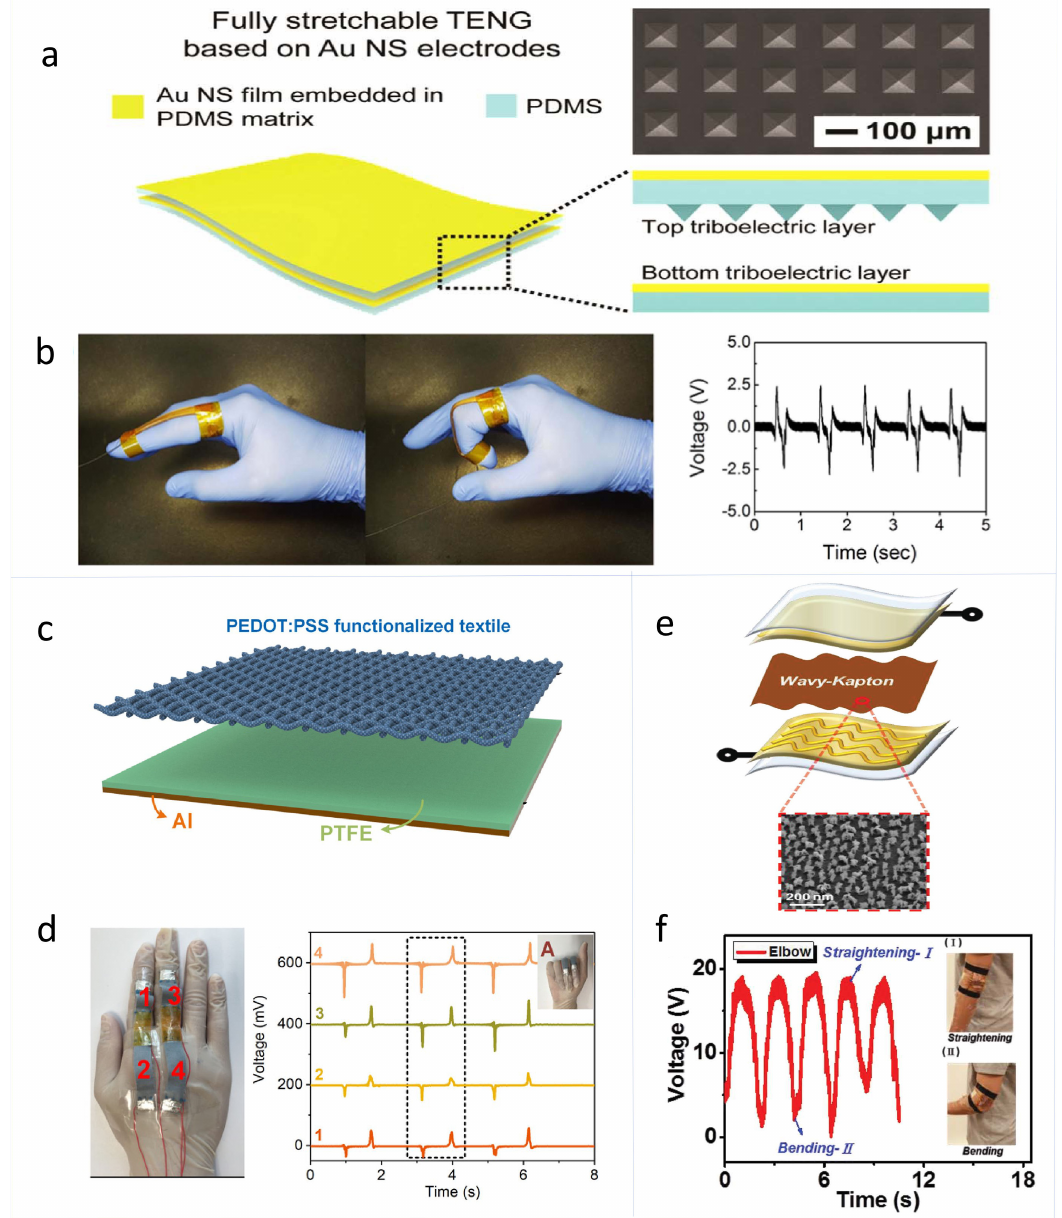
Figure 2. ( a ) Schematic illustration of the structure of the stretchable TENG based on the gold-nanosheet (NS) electrodes. ( b ) Photographs and output-voltage responses to the repeated bending / relaxation of the TENG when installed on the index finger [50]. Copyright 2017, Elsevier. ( c ) Schematic diagram of the structure of PEDOT:PSS functionalized textile based TENG. ( d ) The photographs of the two-arch finger bending sensors installed on the index finger and the middle finger, and output voltages from the four arches when the hand repeats the gestures represented by ‘A’ [51]. Copyright 2018, Elsevier. ( e ) Device structure of the wavy-FTENG. ( f ) Relative changes in voltage versus time for monitoring elbow motion [52]. Copyright 2015,